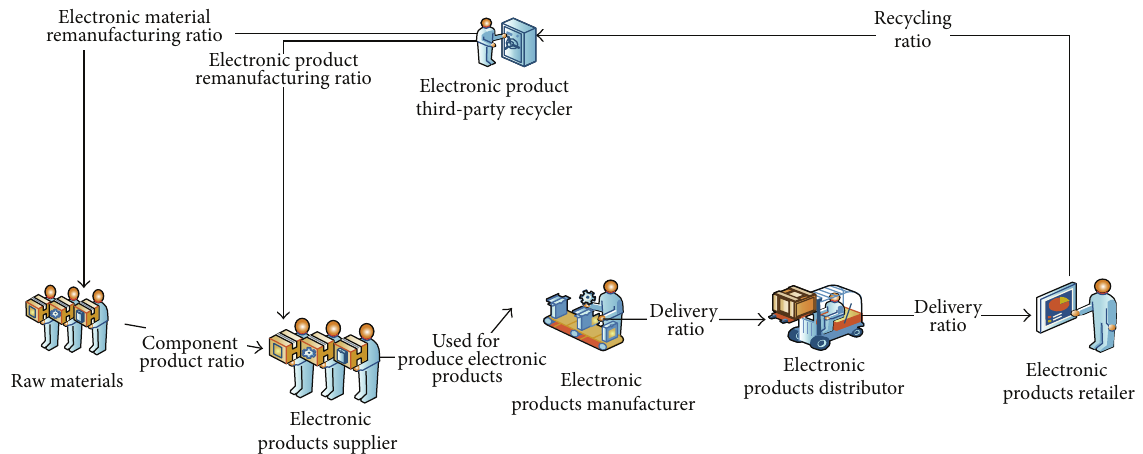
Figure 1: The conception model of electronic products closed-loop supply chain.